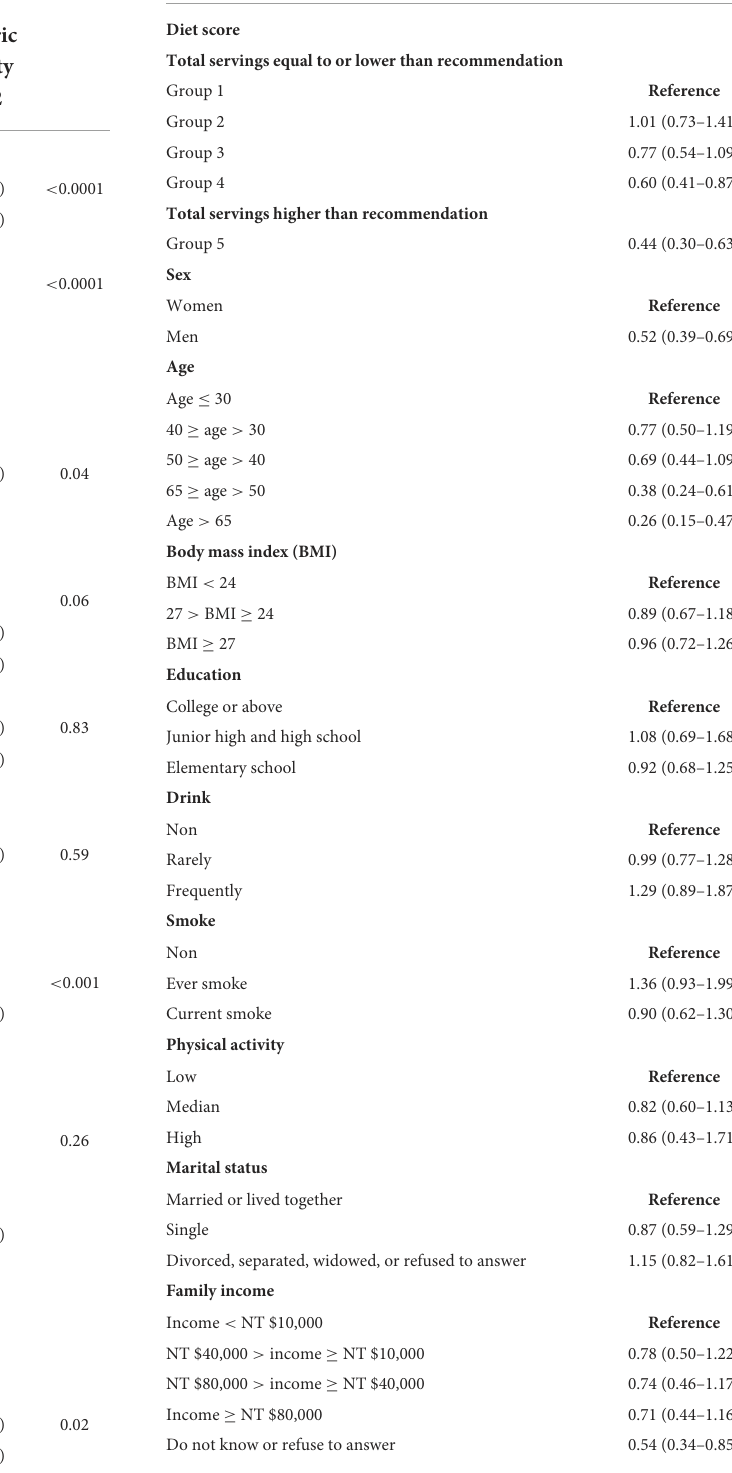
TABLE 2 The relationship between the Daily Food Guide adherence score and the risk of psychiatric